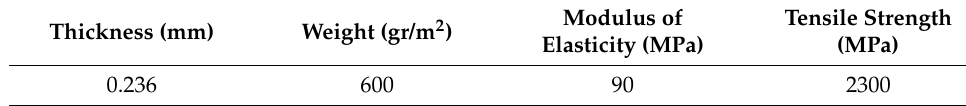
Table 3. Characteristics of GFRP.